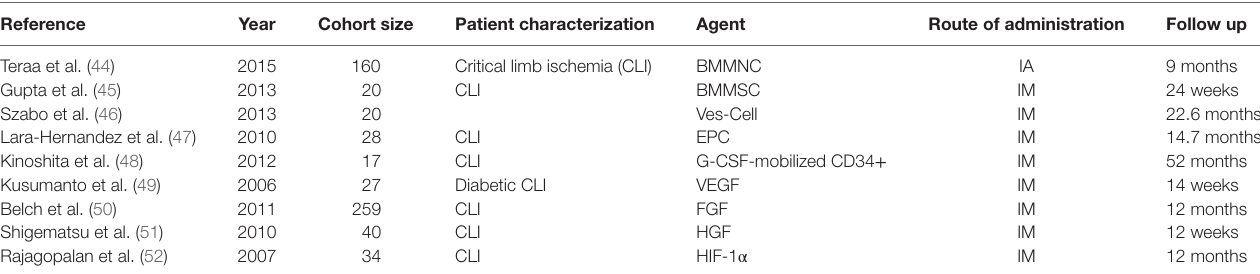
TAbLe 1 | Factors with an angiogenic potential